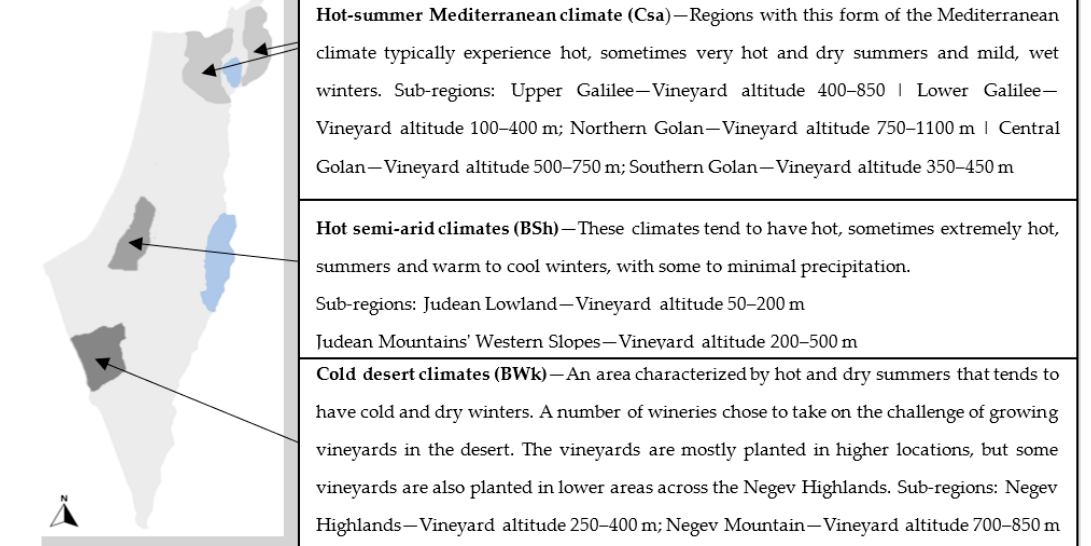
Figure 3. The research areas.